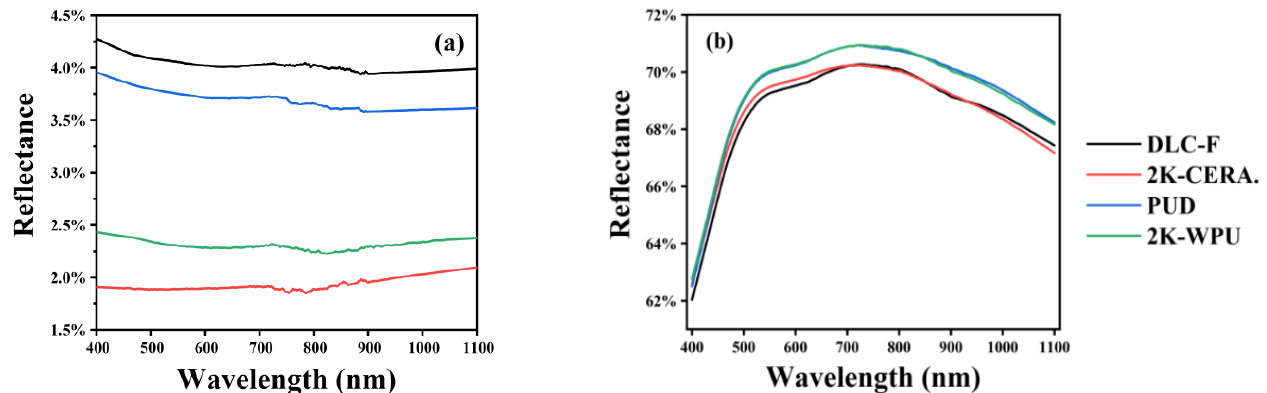
Figure 4. ( a ) Reflectance of primary coating formulations. ( b ) Reflectance of pure resin.